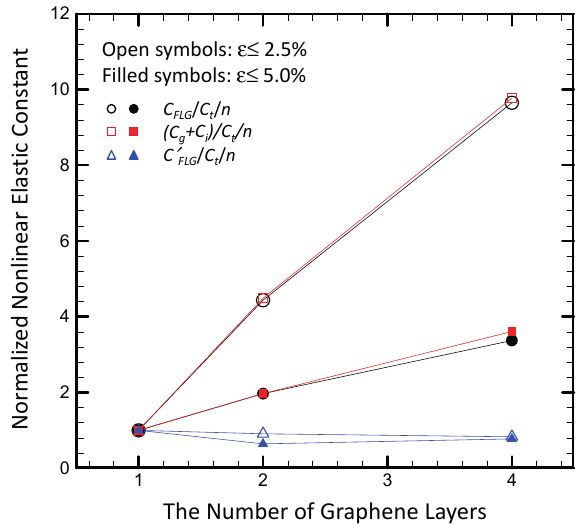
Figure 19. The variation of the normalized third-order nonlinear elastic constant of FLG ( C /C / n ) with the number of layers in FLG. C in t monolayer graphene determined from in-plane